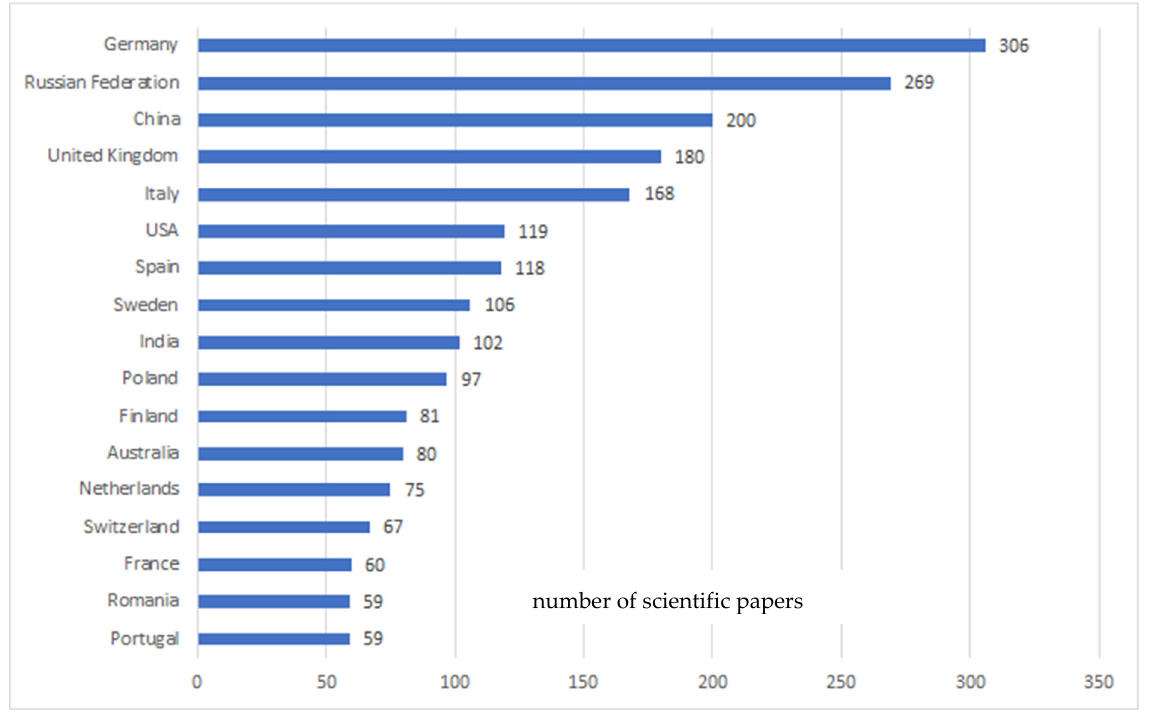
Figure 2. Distribution of scientific papers on the researched topic by country. Source: processing done by the authors based on the data interrogated in the Scopus database .